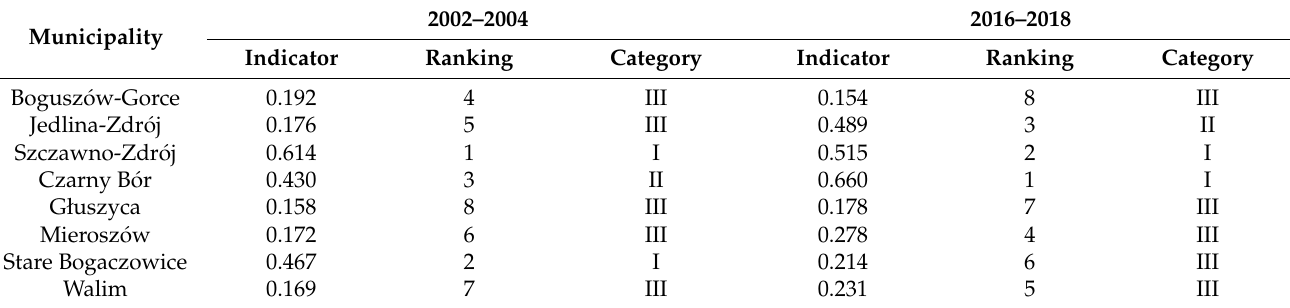
Table 4. Indicators of economic development potential for Wałbrzych County municipalities calculated using zero unita- rization